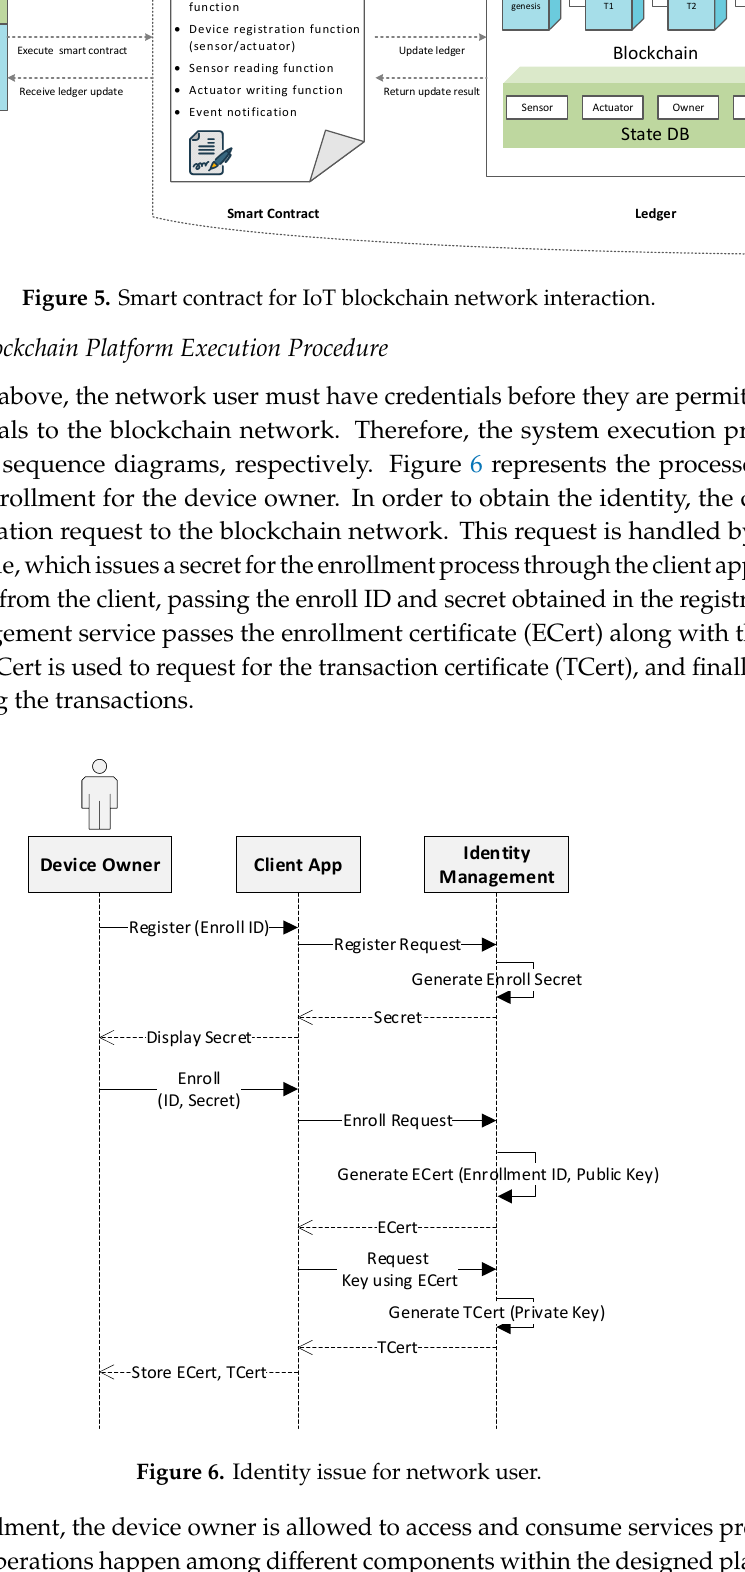
Figure 6. Identity issue for network user.